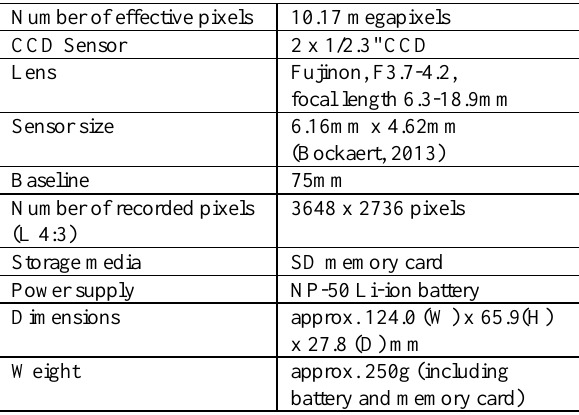
Table 1. Specifications of the Fujfilm Finepix Real 3D W3